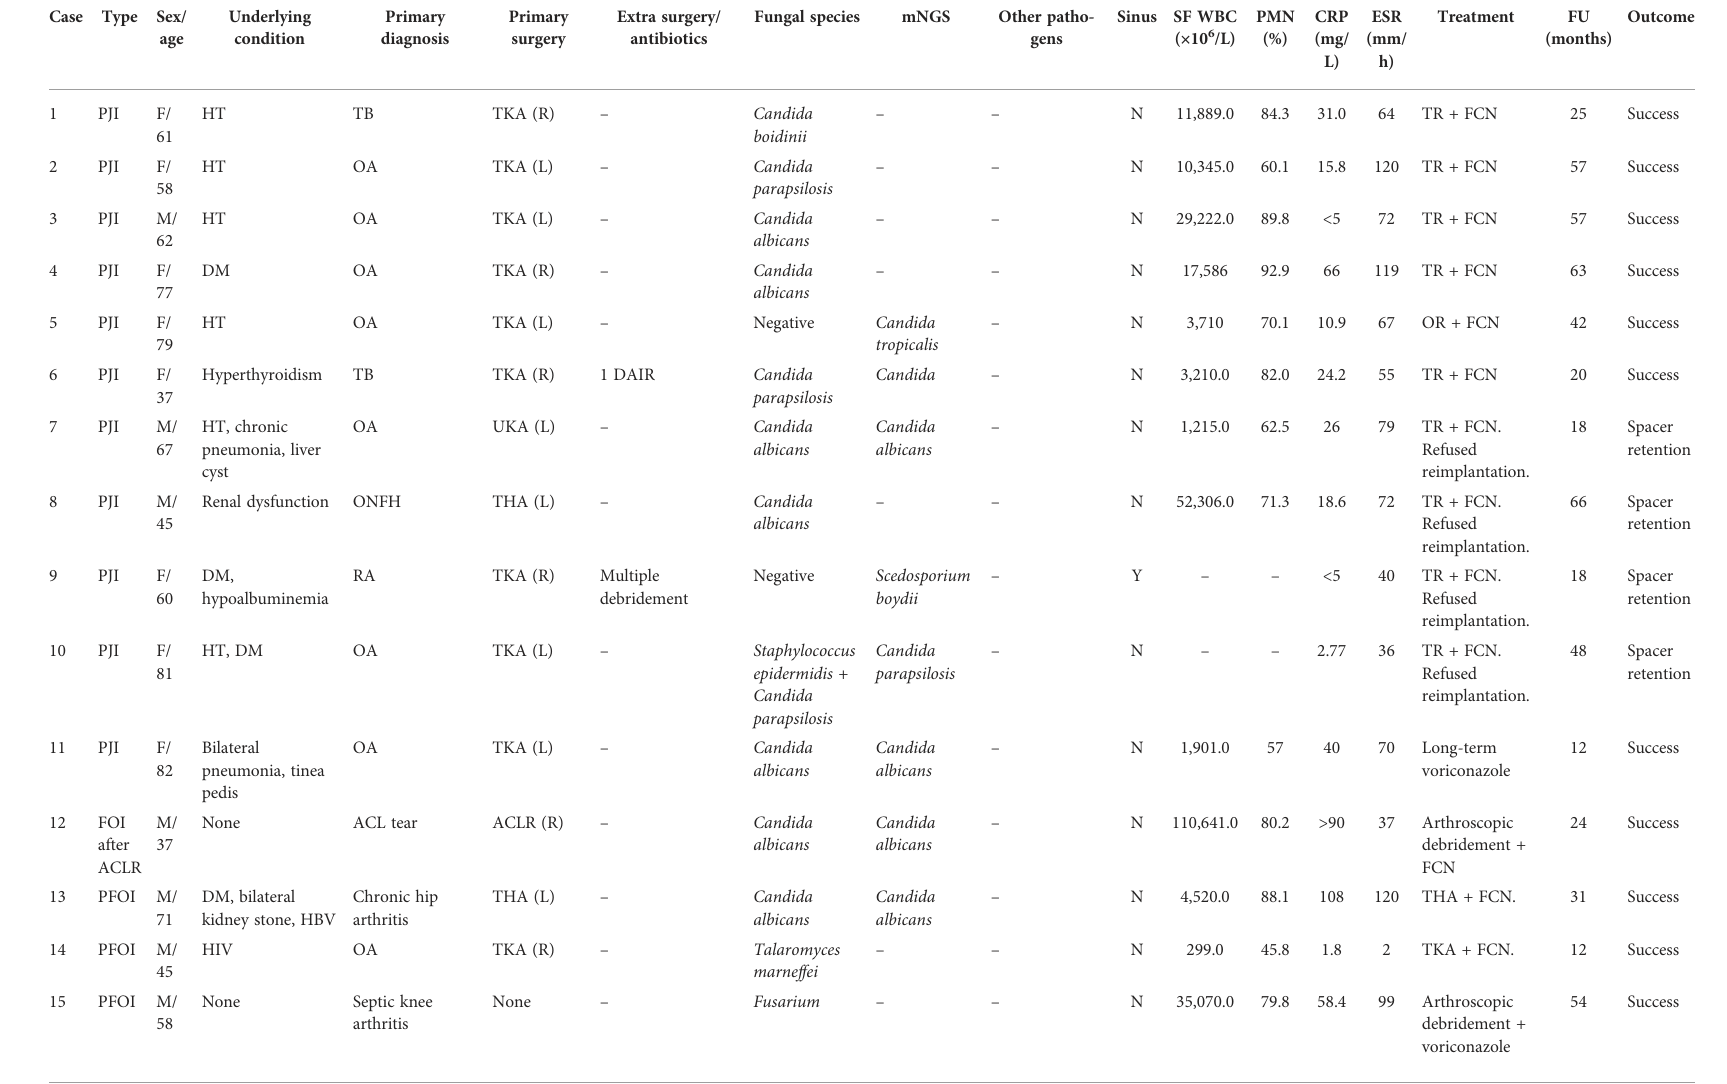
TABLE 1 Demographic information of the 25 patients with fungal osteoarticular infection